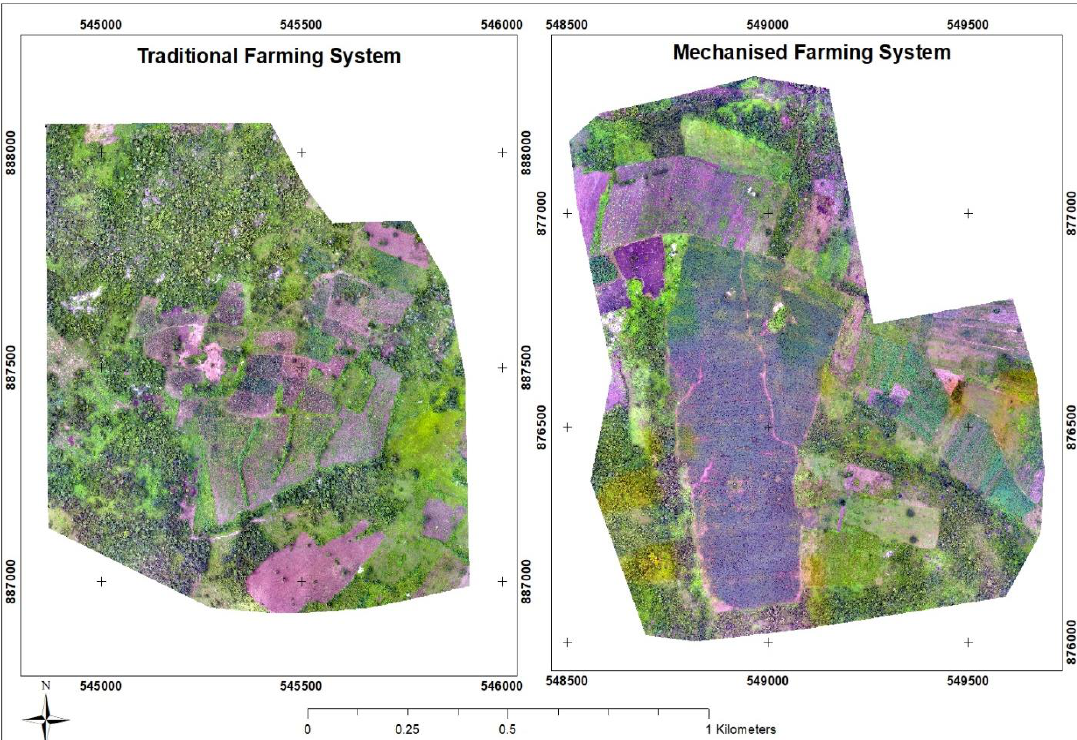
Figure 4. Digital orthomosaic showing traditional (left) and mechanised (right) farmlands